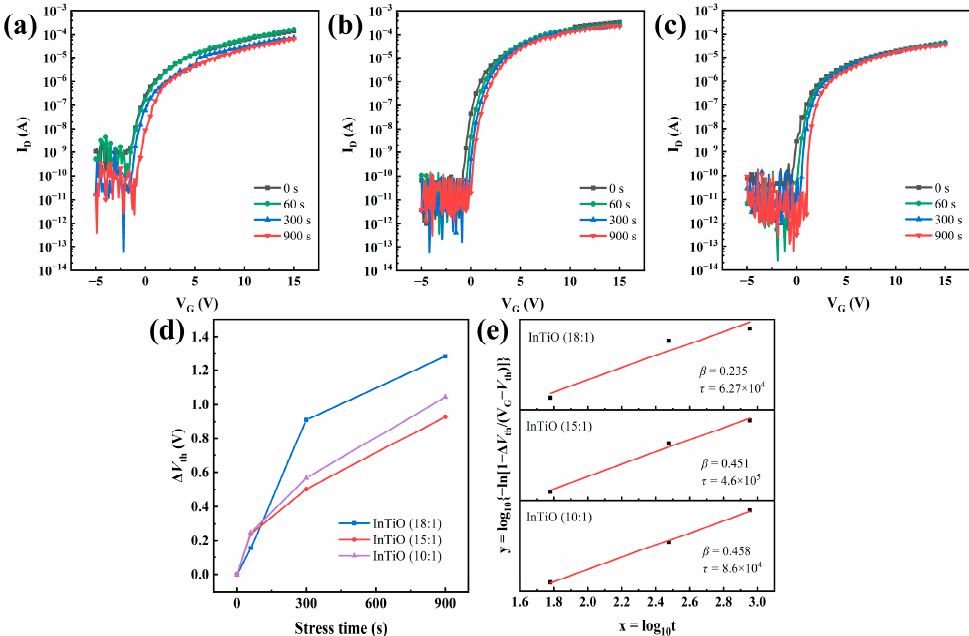
Figure 6. ( a ) The carrier concentration, resistivity, and Hall mobility of InTiO x films deposited on glass substrates. ( b ) The changing trend of contact resistance with doping ratios.